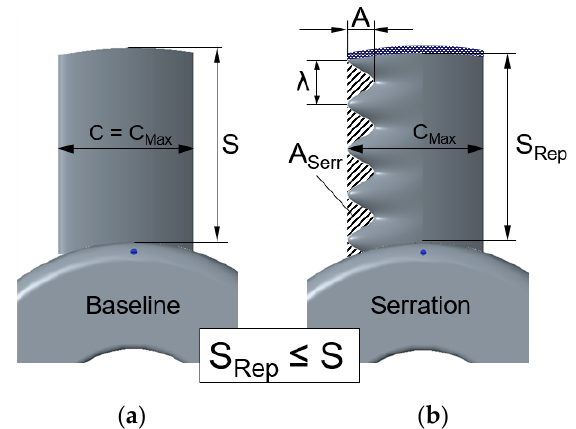
Figure 5. Schematic of leading edge design including measures of importance. Both blades exhibit equal NACA 65(12)-10 properties. ( a ) Baseline case with a straight leading edge; ( b ) Serrated design, where grey hatching indicates reduced wetted area of the blade.